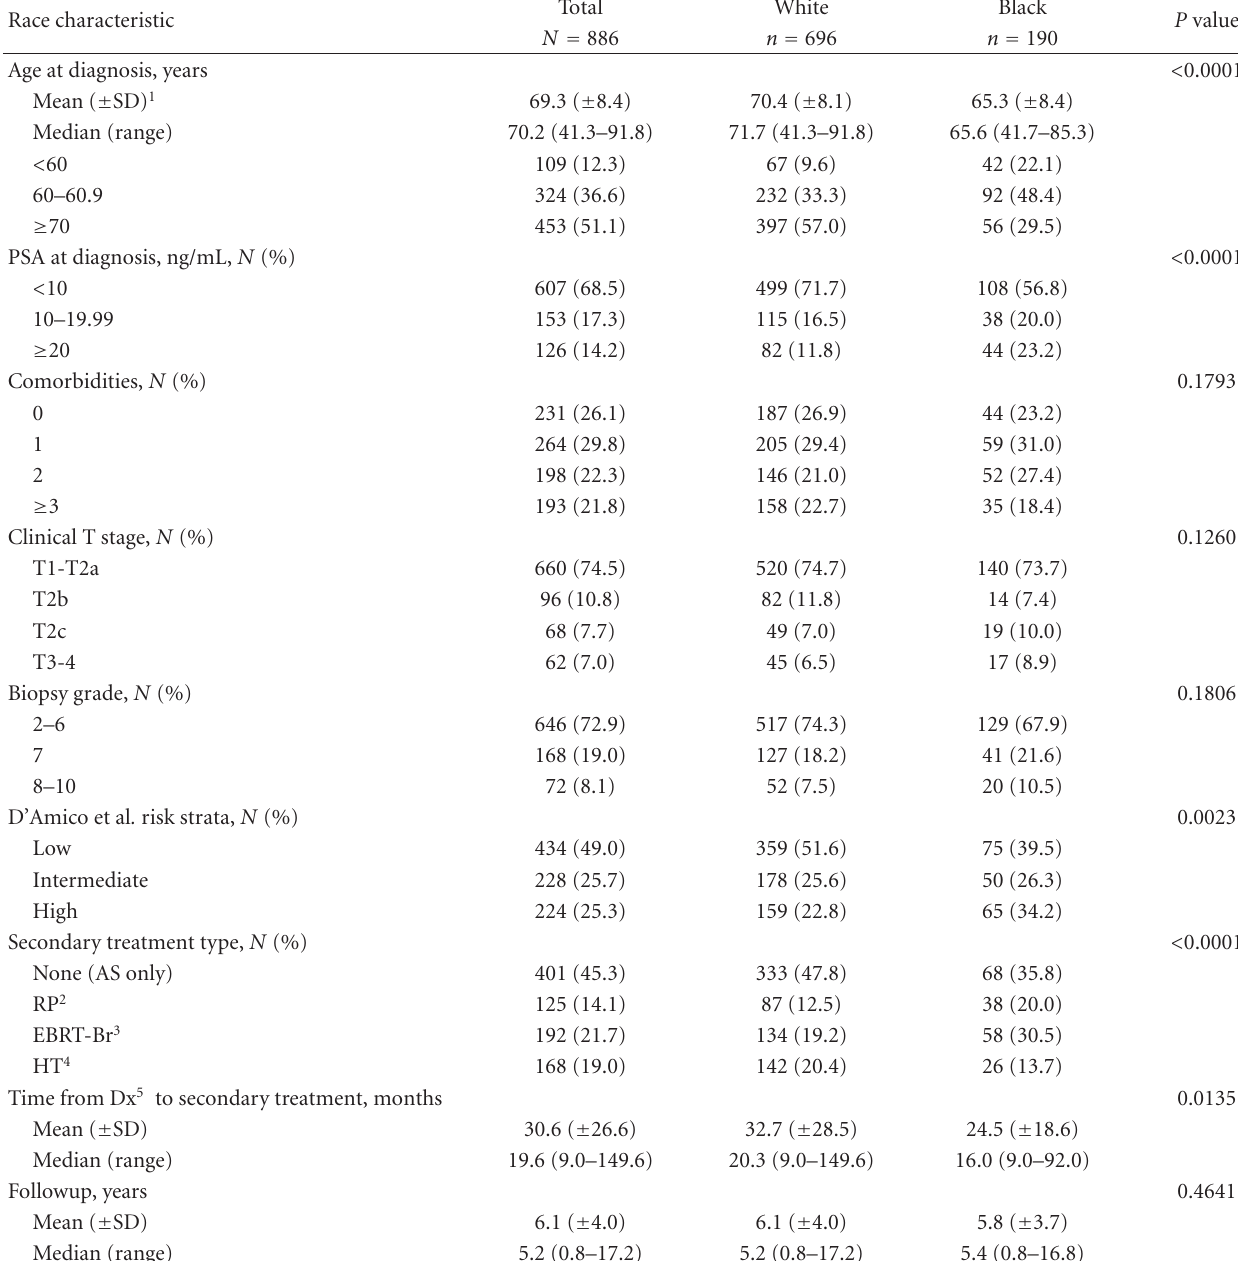
Table 1: Characteristics of subjects with prostate cancer (CaP) followed on active surveillance (AS) for primary treatment, stratified by race ( N =